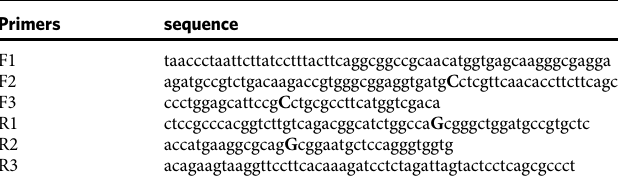
Fig. 5 MTs polymerisation/depolymerisation can increase/decrease cell apical area. a Schematic of the injection in the Drosophila pupae. b , c Timeline of the injection protocol and colcemid inactivation experiment (see “ Methods ” ) and EB1-GFP signal (pseudocolour) before injection, 1.5 h after injection and after few minutes of colcemid inactivation by UV. Scale bars are 5 µ m. d Snapshot of the different experimental regions after colcemid injection, single plane. Top, E-cad-tdTomato, bottom, EB1-GFP (pseudocolour, note the disappearance of MT fi lament). Green, control region shown in ( e ). Blue, UV- exposed region shown in ( f ). Scale bar, 10 μ m. e , f Snapshots of a control region ( e ) and UV-exposed region ( f ) after colcemid injection. Top, E-cad- tdTomato. Bottom shows EB1-GFP (pseudocolour). Scale bars are 5 µ m. Orange and red contour, single representative cell at t 0 and 4 min. g Examples of cell area evolution, orange t 0 , red 4 min post UV exposition in the control region (left) or UV-exposed region (right). h Quanti fi cation of the cell perimeter fold changes. Col: colcemid. Green boxplot, colcemid without UV pulses, blue boxplot, colcemid and UV. N = 4 colcemid injected pupae, 3 control pupae, n > 30 cells per condition (one dot = one cell). Each boxplot shows the median value (middle line), and 25th and 75th percentiles. The whiskers show the most extreme data points not considered outliers. Outliers are plotted in red. P value, two-sided t test. i sqh-mKate (MRLC, purple, greyscale bottom) and a clone expressing UAS-LARIAT and UAS- α Tubulin-GFP (green dotted line, clone contours). Arrows show GFP clusters forming after 488-nm exposure. t 0 , start of the movie. The white box highlights the cell shown in ( j ). The scale bar is 10 µ m. j Snapshot of sqh-mKate in a cell upon LARIAT activation. Scale bar is 5 µ m. k Normalised averaged perimeter upon LARIAT clusterisation of α Tubulin-GFP (dark green) compared to control cells (grey, outside the clone) or in control cells expressing UAS-LARIAT and UAS-GFP cytoplasmic (light green). N = 3 pupae for each, n = 41 WT and UAS-Lariat, UAS- α